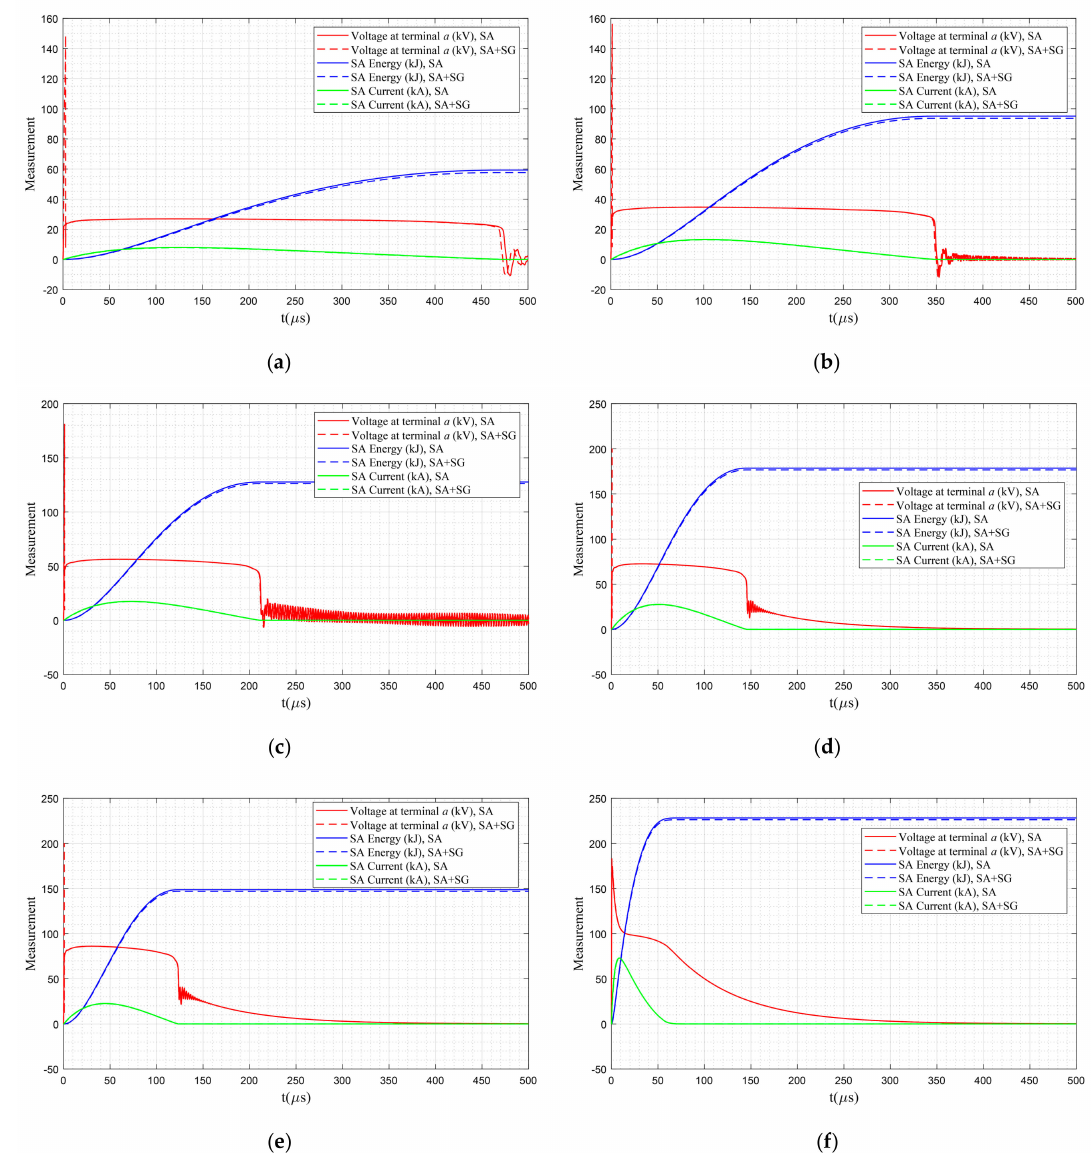
Figure 31. Comparison of the energy absorbed by di ff erent surge arresters against the 200 kV lightning impulse: ( a ) 1 mH filtered SA-12b, ( b ) 500 µ H filtered SA-18b, ( c ) 250 µ H filtered SA-24b, ( d ) 100 µ H filtered SA-30b, ( e ) 100 µ H filtered SA-36b, and ( f ) non-filtered